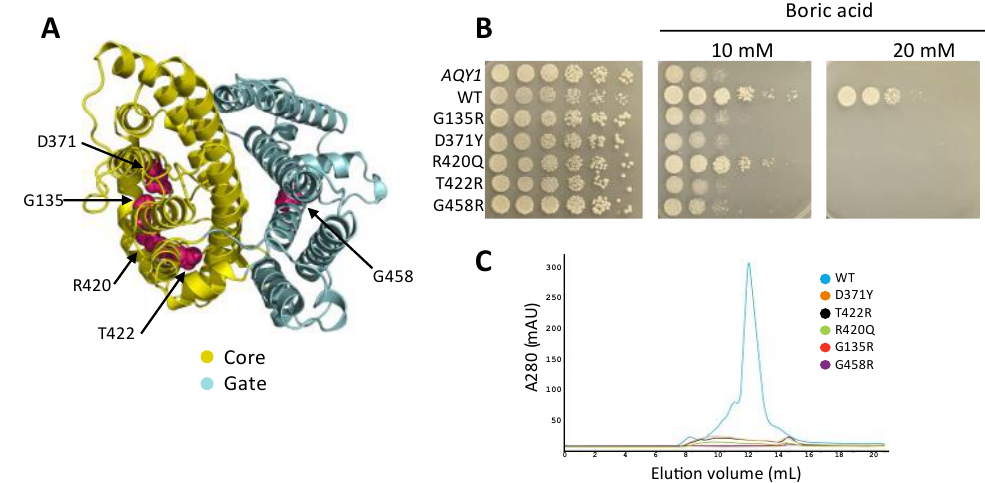
Figure 5. Impacts of disease-causing mutations in human SLC4A1 transfer to ScBor1p. ( A ) AlphaFold model of ScBor1p with homologous locations of disease-causing mutations in SLC4A1 in pink. ( B ) Plasmids encoding the specified ScBor1p mutant were tested against the indicated boric acid concentrations. Plates were incubated at 30 °C and imaged after 5 days. ( C ) Superposed chromatograms from size-exclusion chromatography performed for wild-type and mutant ScBor1p.